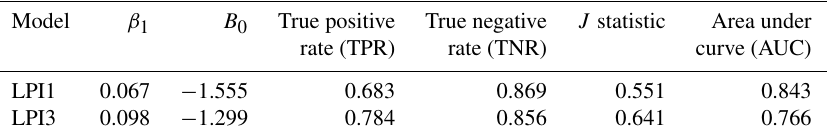
Table 7. Coefficients of link function and summary of contingency table analysis for the two best-performing LPI models. Refer to Table 4 for descriptions corresponding to model